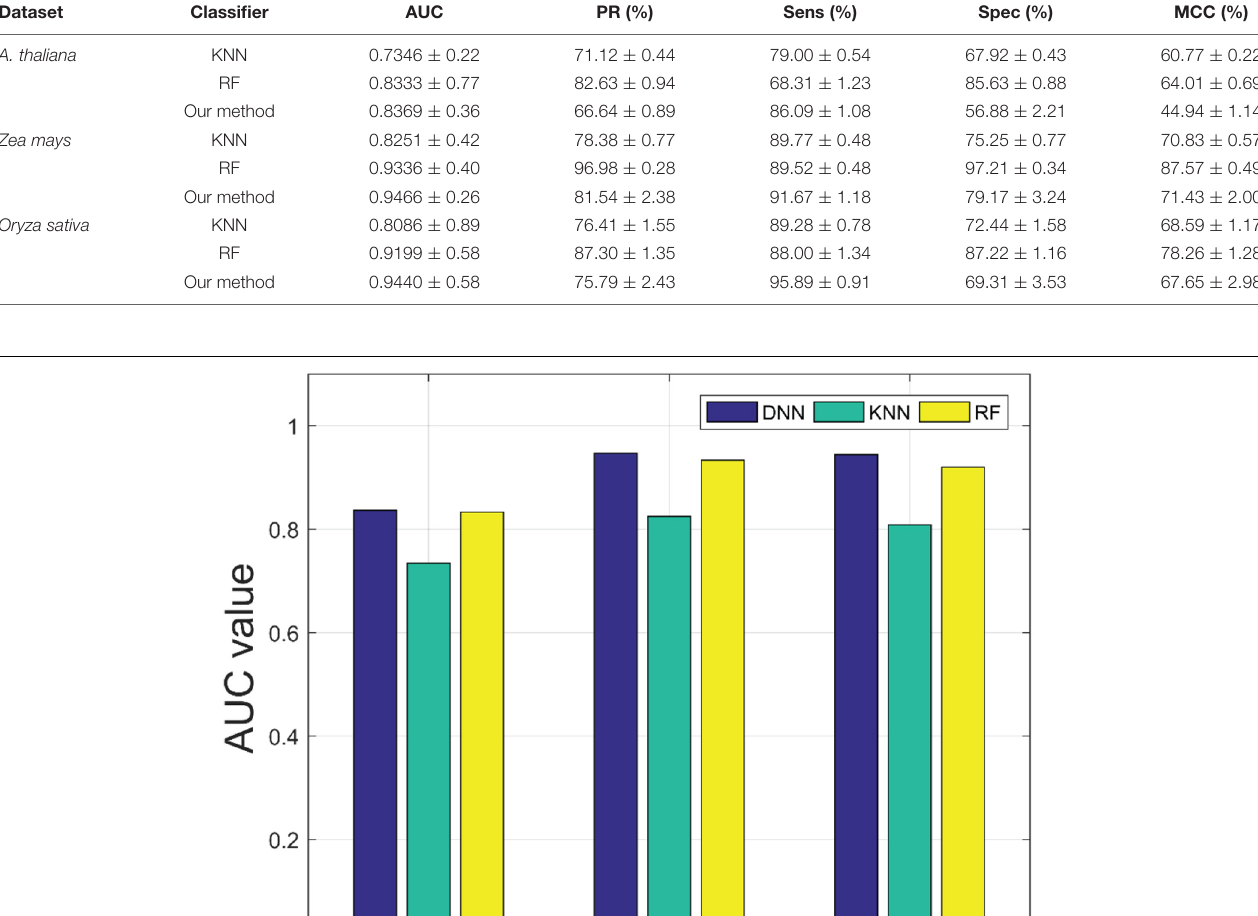
Frontiers in Genetics |